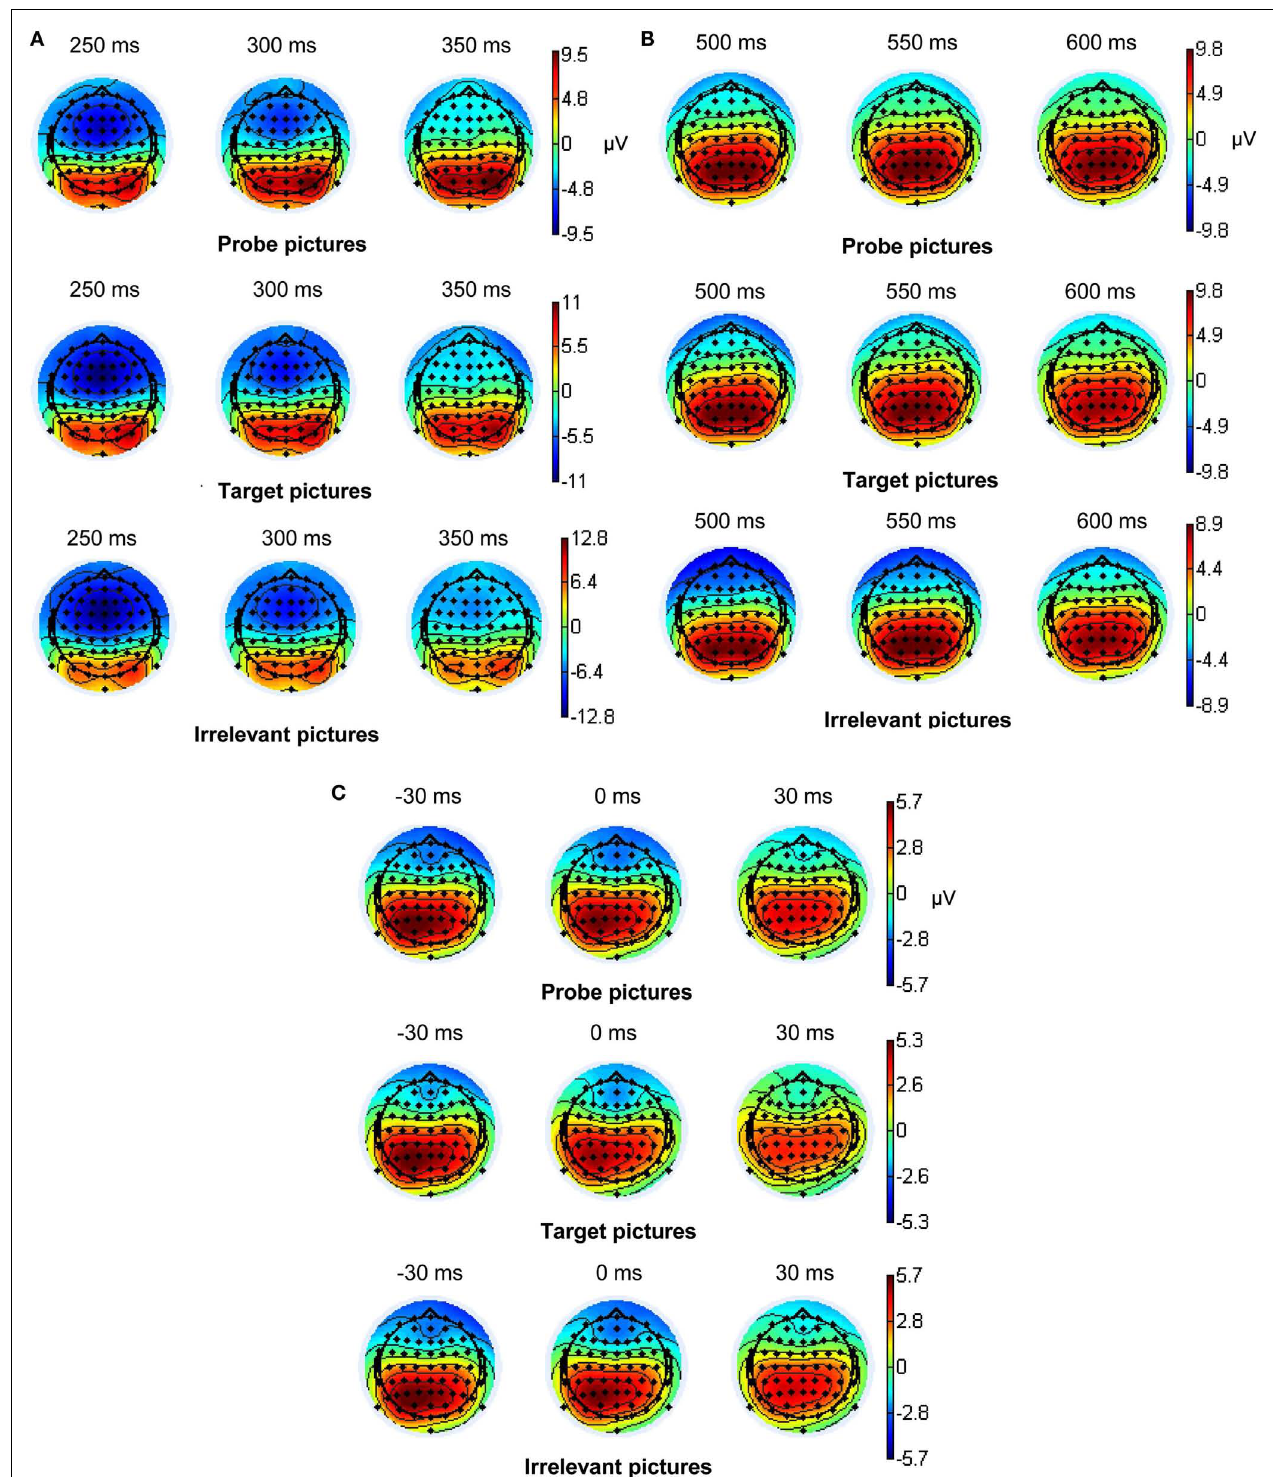
FIGURE 3 | (A) Topographic maps of the early stimulus-locked P3 component ( N = 102), (B) the late stimulus-locked P3 component, and (C) topographic maps of the response-locked MFN component ( N = 91).